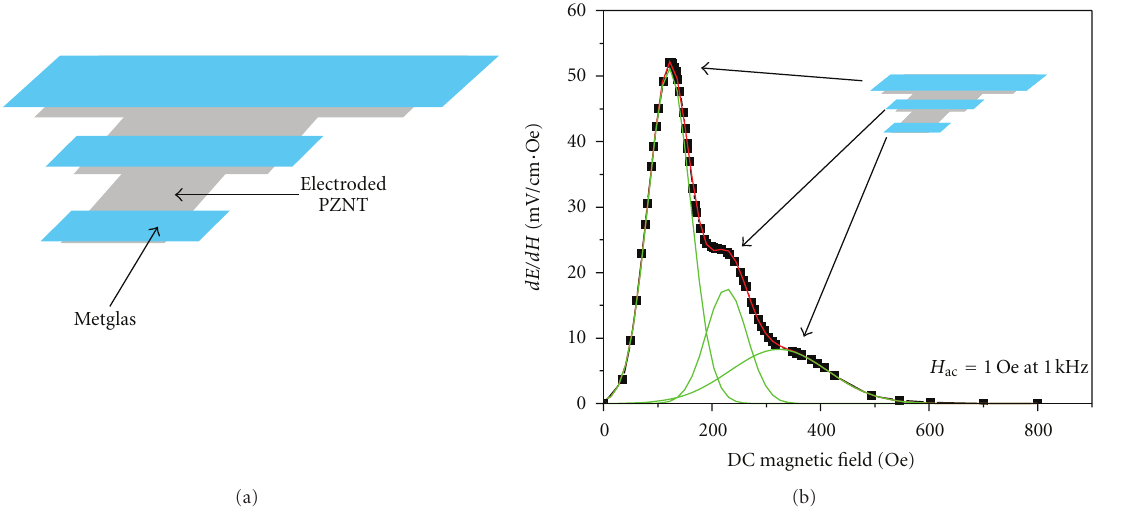
Figure 7: (a) Schematic structure of the dimensionally gradient laminate composite. 20 layers of Metglas were attached on each rectangular section, (b) ME coe ffi cient of the dimensionally gradient sample under H ac = 1Oe at 1 kHz